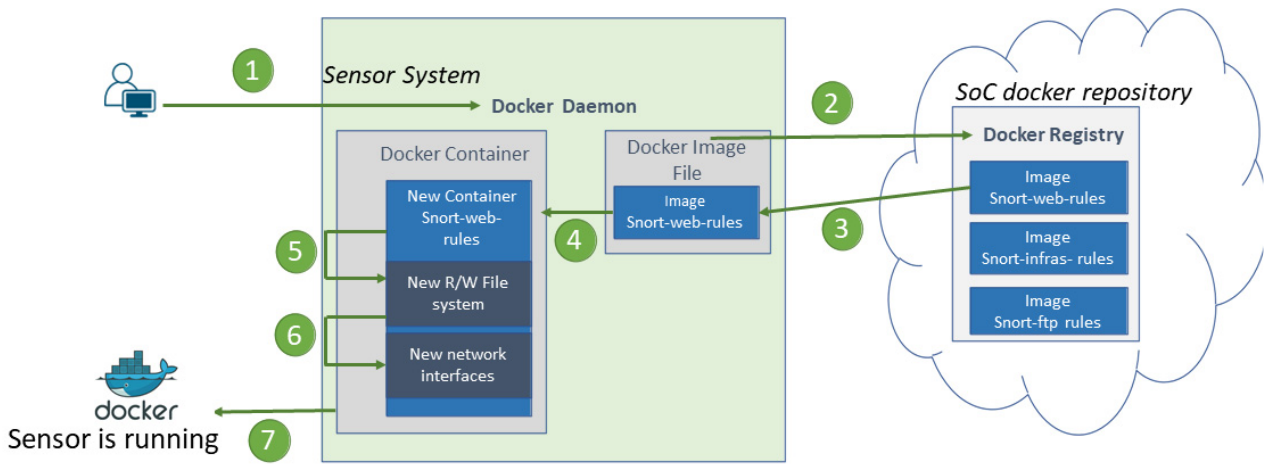
Figure 7. The process for creating a new docker container for the sensor (Snort-based NIDS with pre-configured web rules).